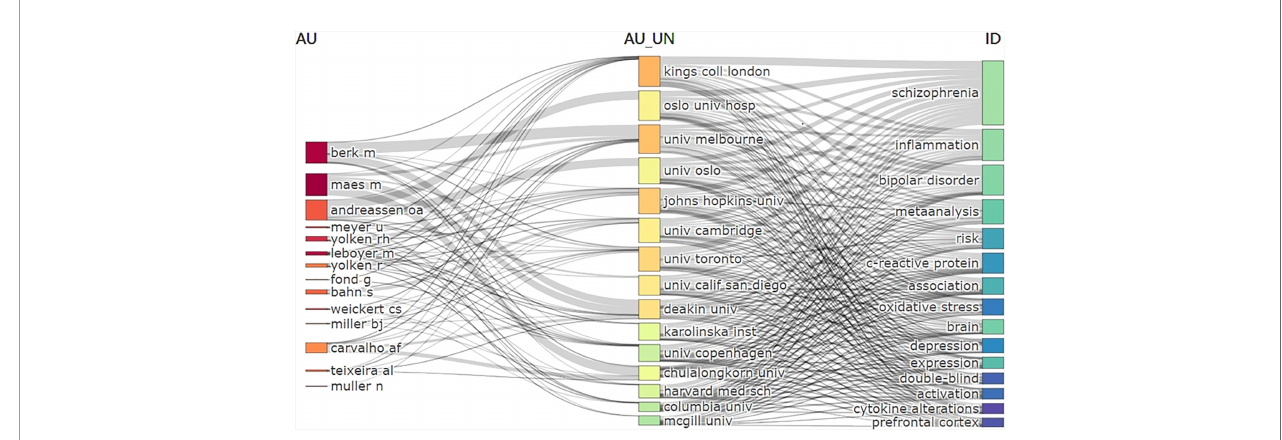
FIGURE 5 | Three- fi eld plot of the Keywords Plus analysis on schizophrenia and in fl ammation Notes: three- fi eld plot of the keywords plus analysis: (middle fi eld: af fi liations; left fi eld: authors; right fi eld: keywords